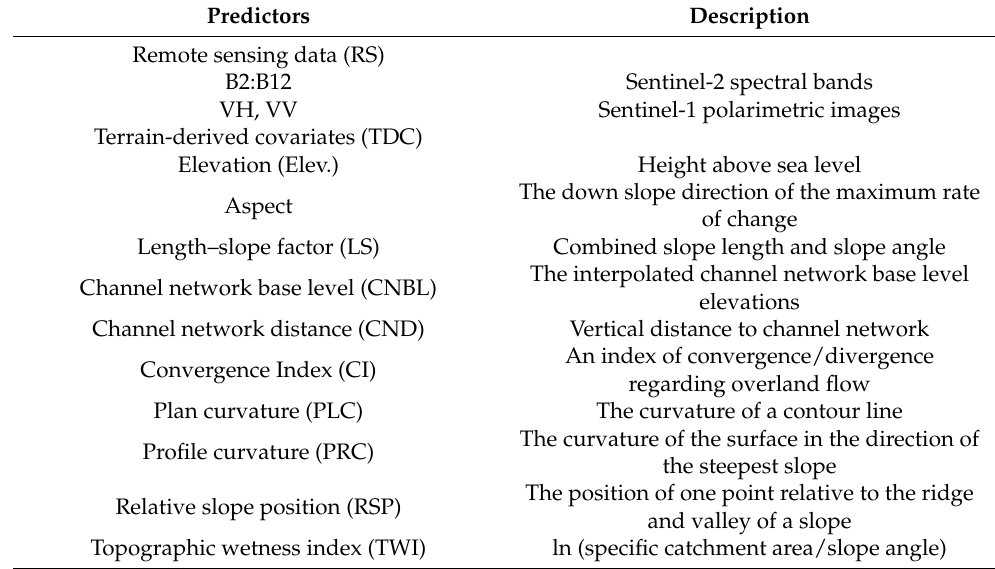
Table 1. Terrain-derived covariates and remote sensing data used for predicting soil texture